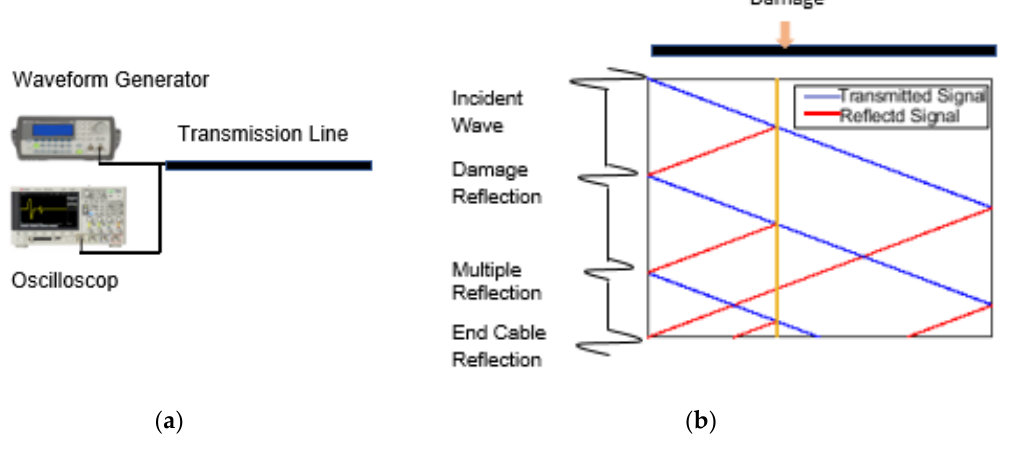
Figure 3. ( a ) The simplest ETDR experimental setup uses a waveform generator and oscilloscope connected to the transmission line. ( b ) The principle of multiple reflections is illustrated.